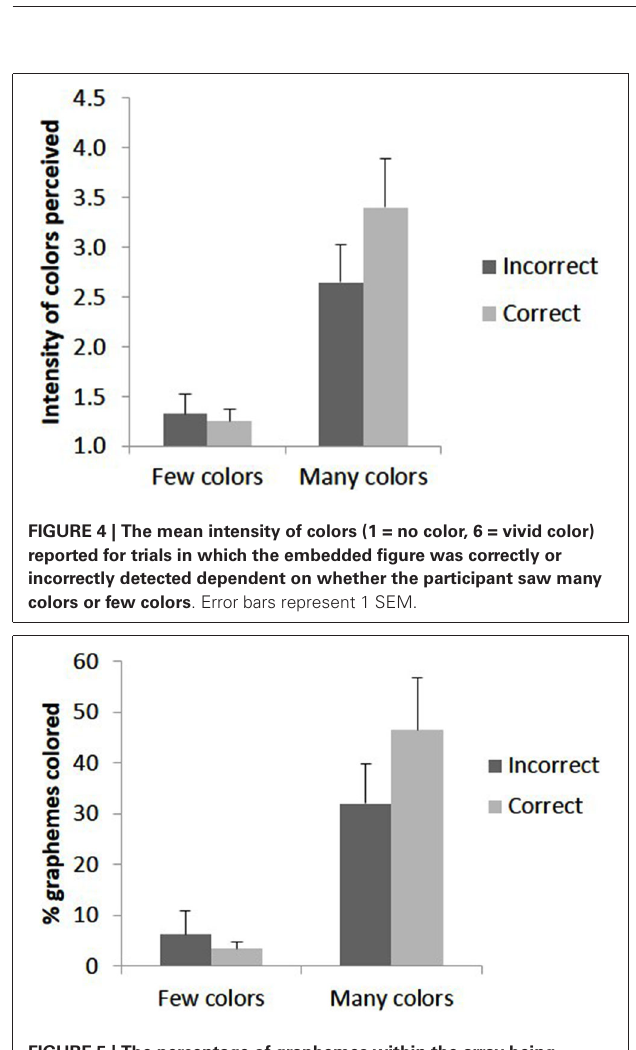
FIGURE 5 | The percentage of graphemes within the array being reported as colored for trials in which the embedded figure was correctly or incorrectly perceived . Error bars represent 1 SEM.